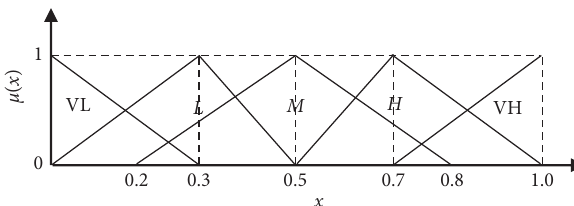
Figure 2: Membership functions for ranking indices.